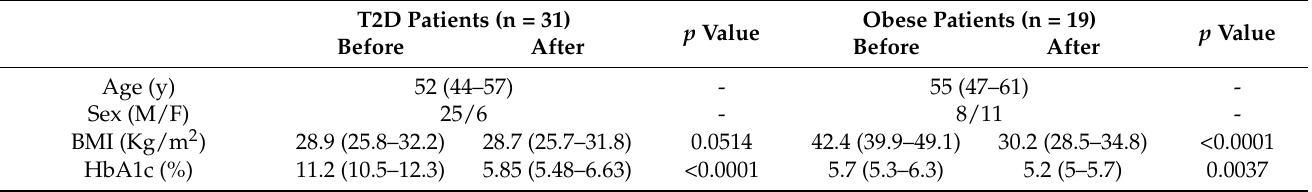
Table 1. Characteristics of T2D patients before and after glycemic optimization, and obese subjects before and after bariatric